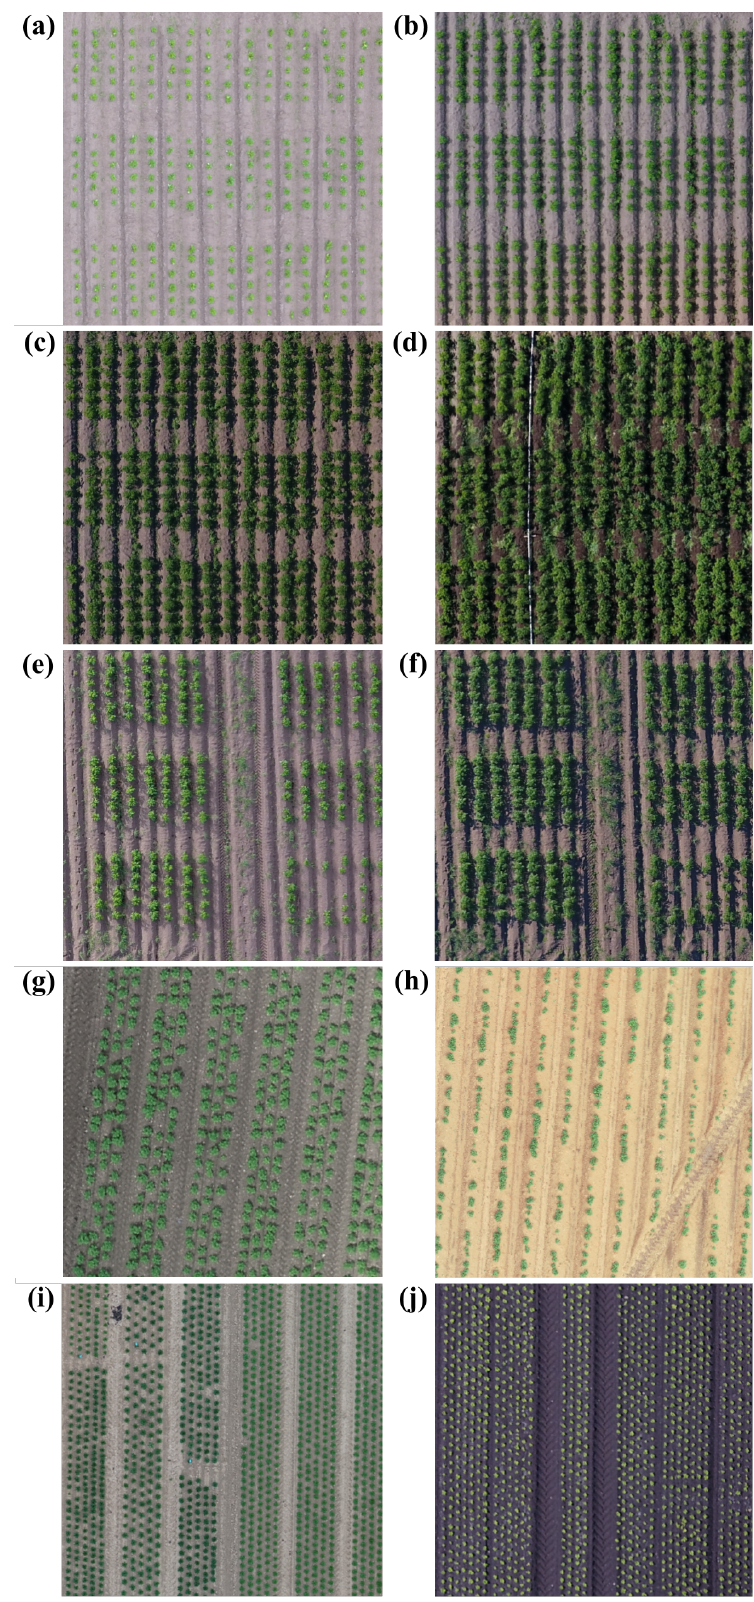
Figure 1. Samples of 10 × 10 m from every single orthomosaic image from our datasets: ( a – d ) P1; ( e , f ) P2; ( g ) P3; ( h ) P4; ( i ) L2; ( j )